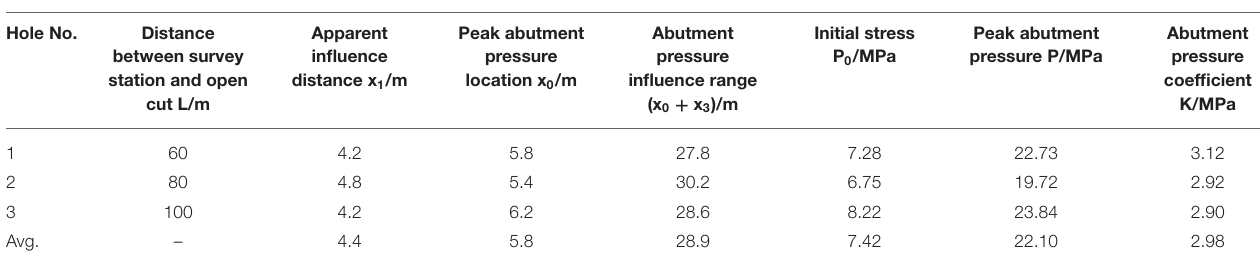
TABLE 2 | Abutment pressure at different survey stations. Hole